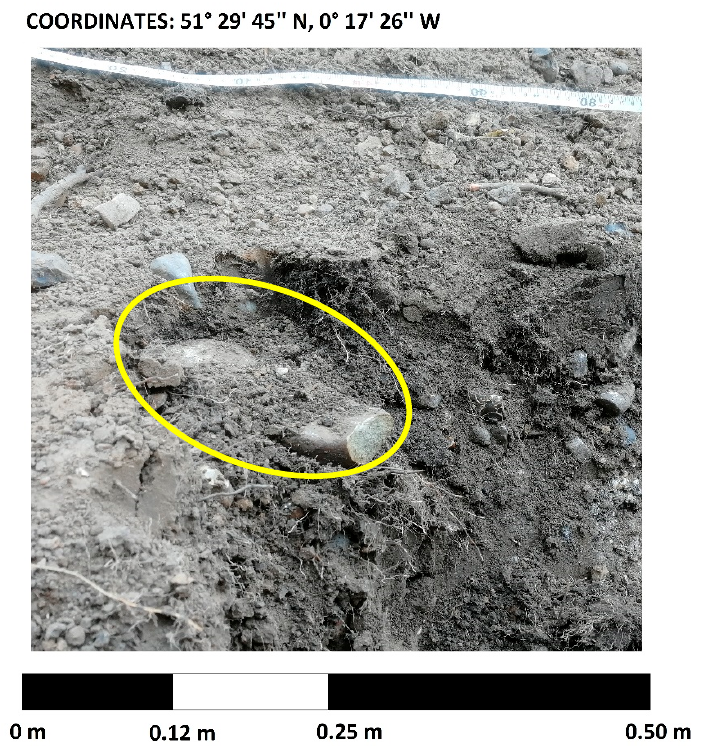
Figure 22. Boulders found along the top edge of the excavation area. The boulder in the foreground has a main axial dimension of approximately 0.15 m.